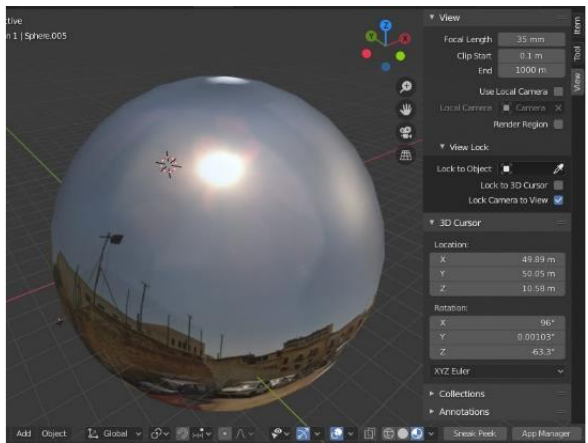
Figure 12. Positioning and texturing of the environmental spheres.